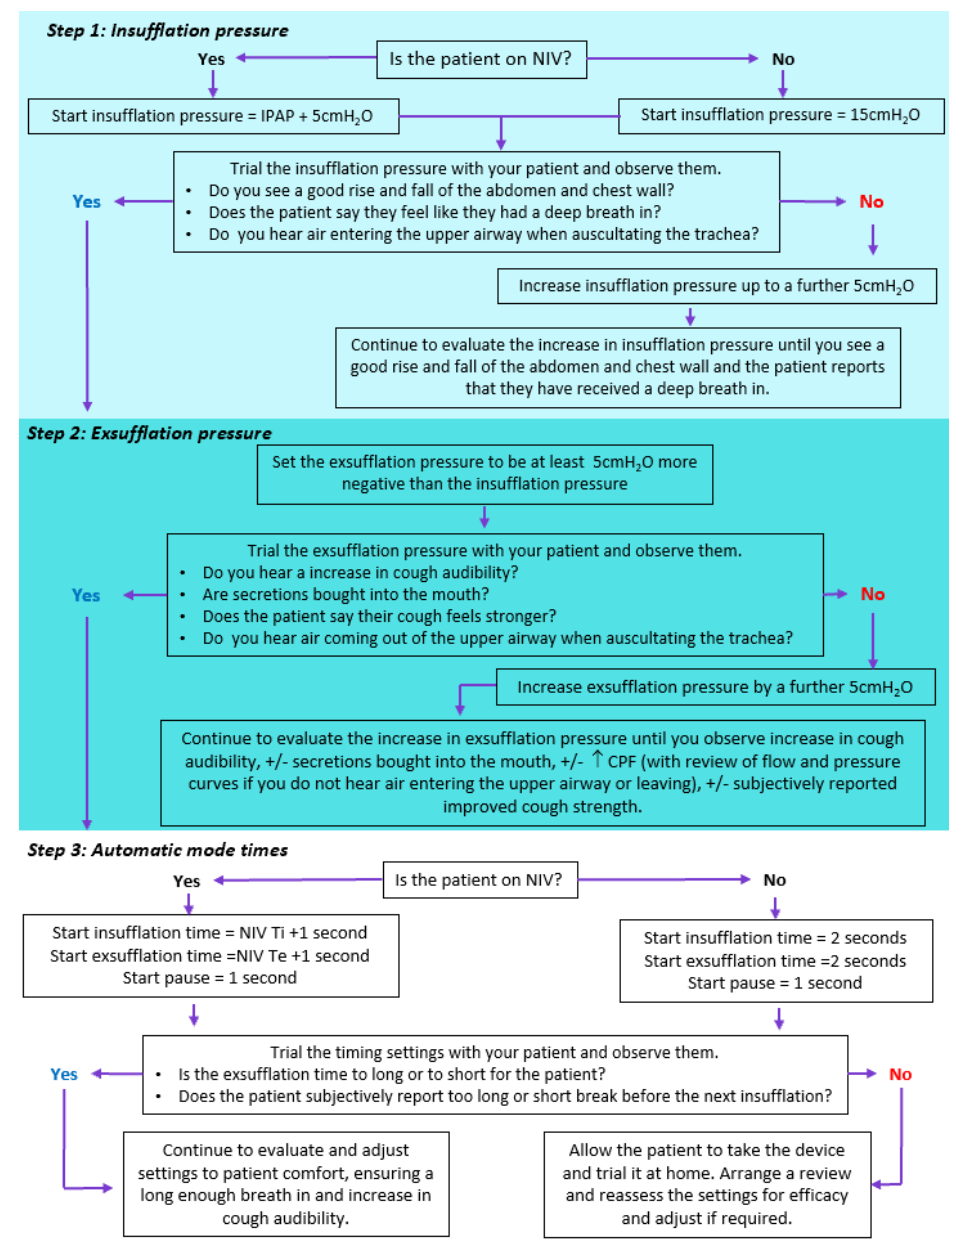
Figure 4. Shows a suggested algorithm for personalized approach to titration of mechanical insufflation-exsufflation (MI-E) devices in adult patients. This algorithm is modified from Chatwin and Simonds [57], taking into account more recent evidence around MI-E times and also MI-E-assisted cough peak flow (CPF). Inspiratory time (Ti), expiratory time (Te).